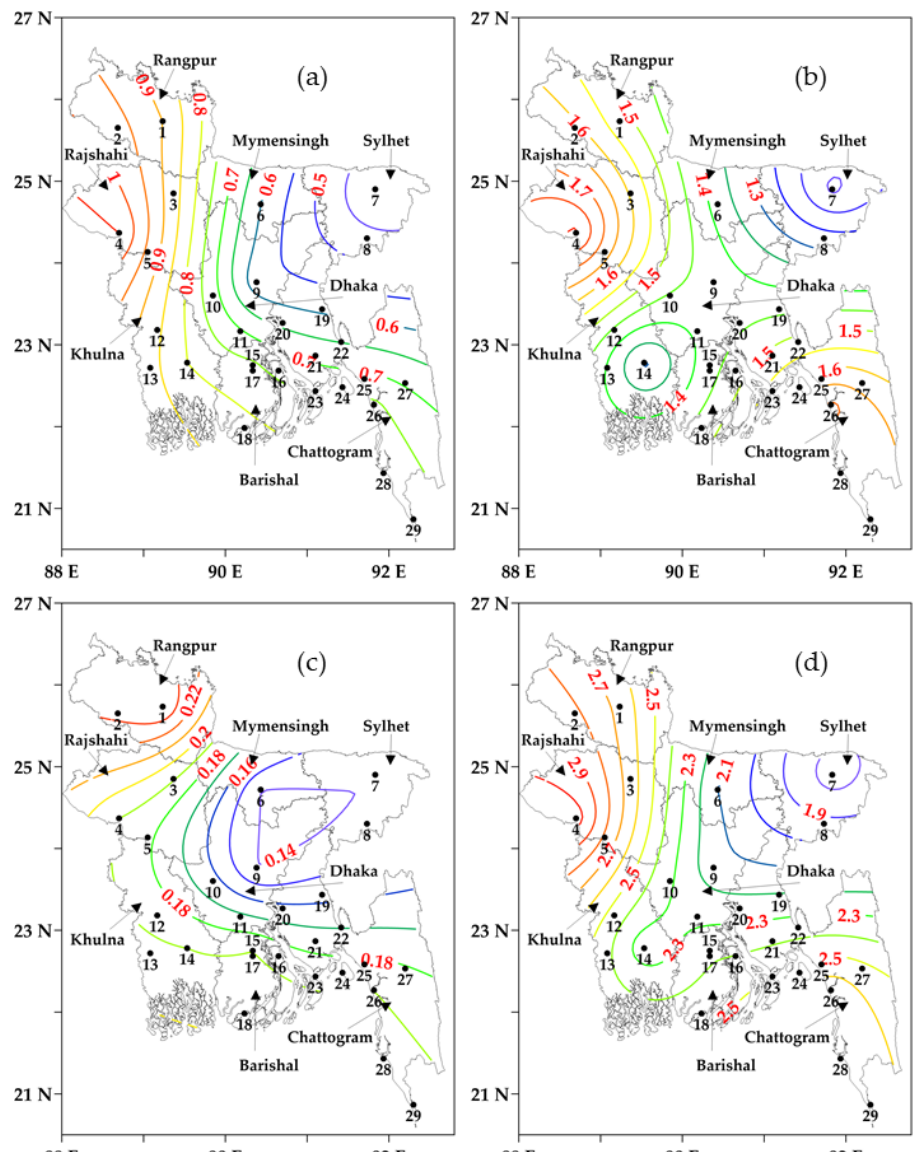
Figure 6. The average number of cold spells (in coloured contour lines with values) in ( a ) December, ( b ) January, ( c ) February, and ( d ) Winter in different divisions of Bangladesh during the winters of 2000–2001 to 2020–2021. The black numbers are the IDs of meteorological